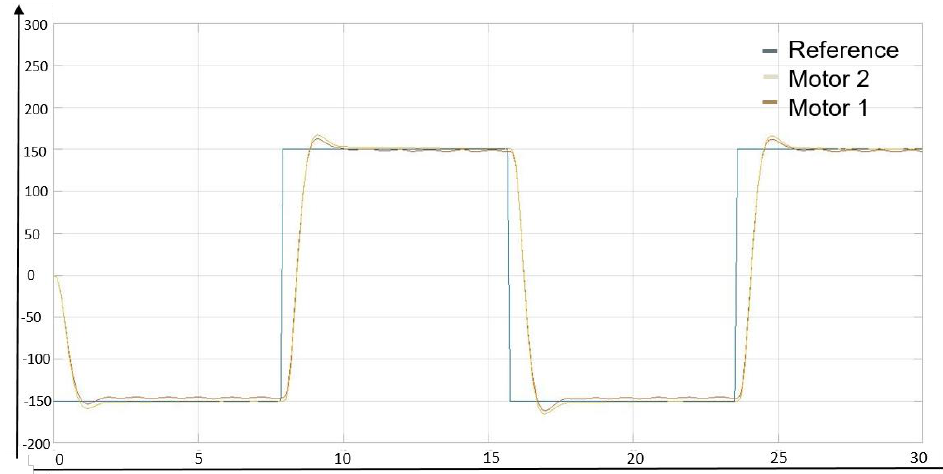
Figure 6. Behavior using PI with optimization values, test 19.